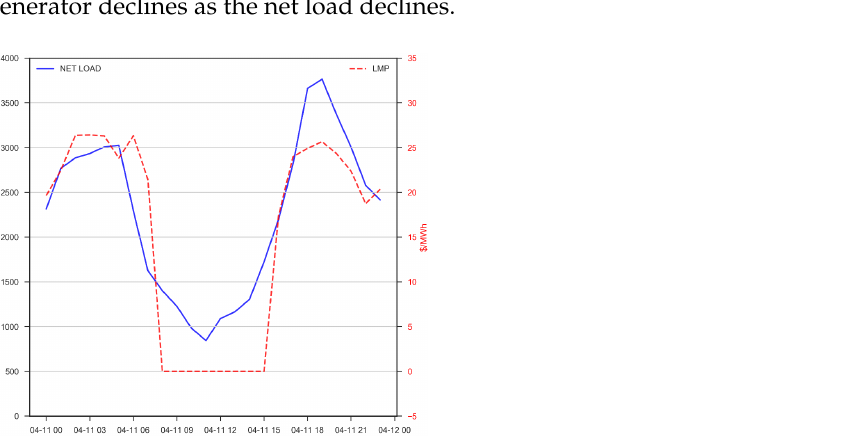
Figure 8. Net load after VRE curtailment and LMP for one day during Duck week (April) for the RTS-GMLC model without EVs. RTS-GMLC model without